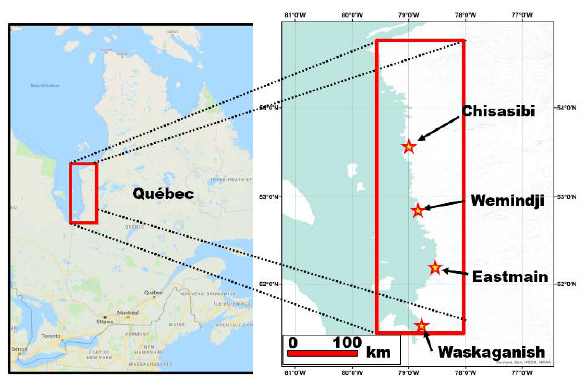
Figure 1. Location the four main Cree coastal communities along the Western coastline of